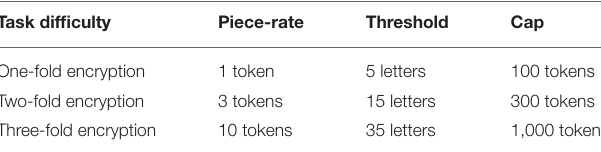
TABLE 3 | Payoff by level of task difficulty in the encryption